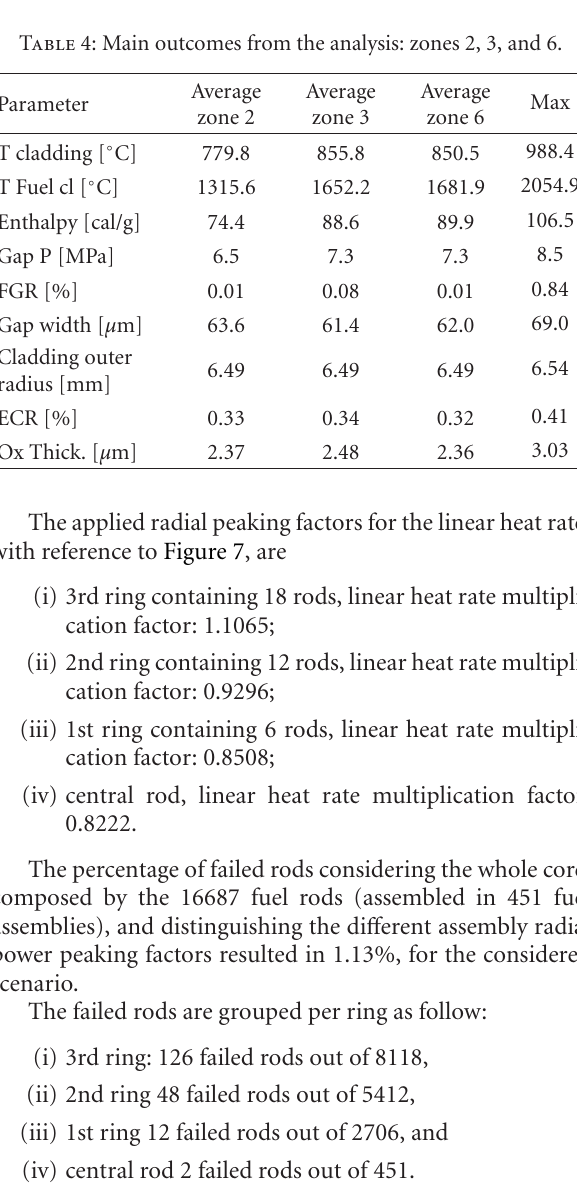
Figure 12: Outer cladding radius as a function of burnup, reference case and all the rods.